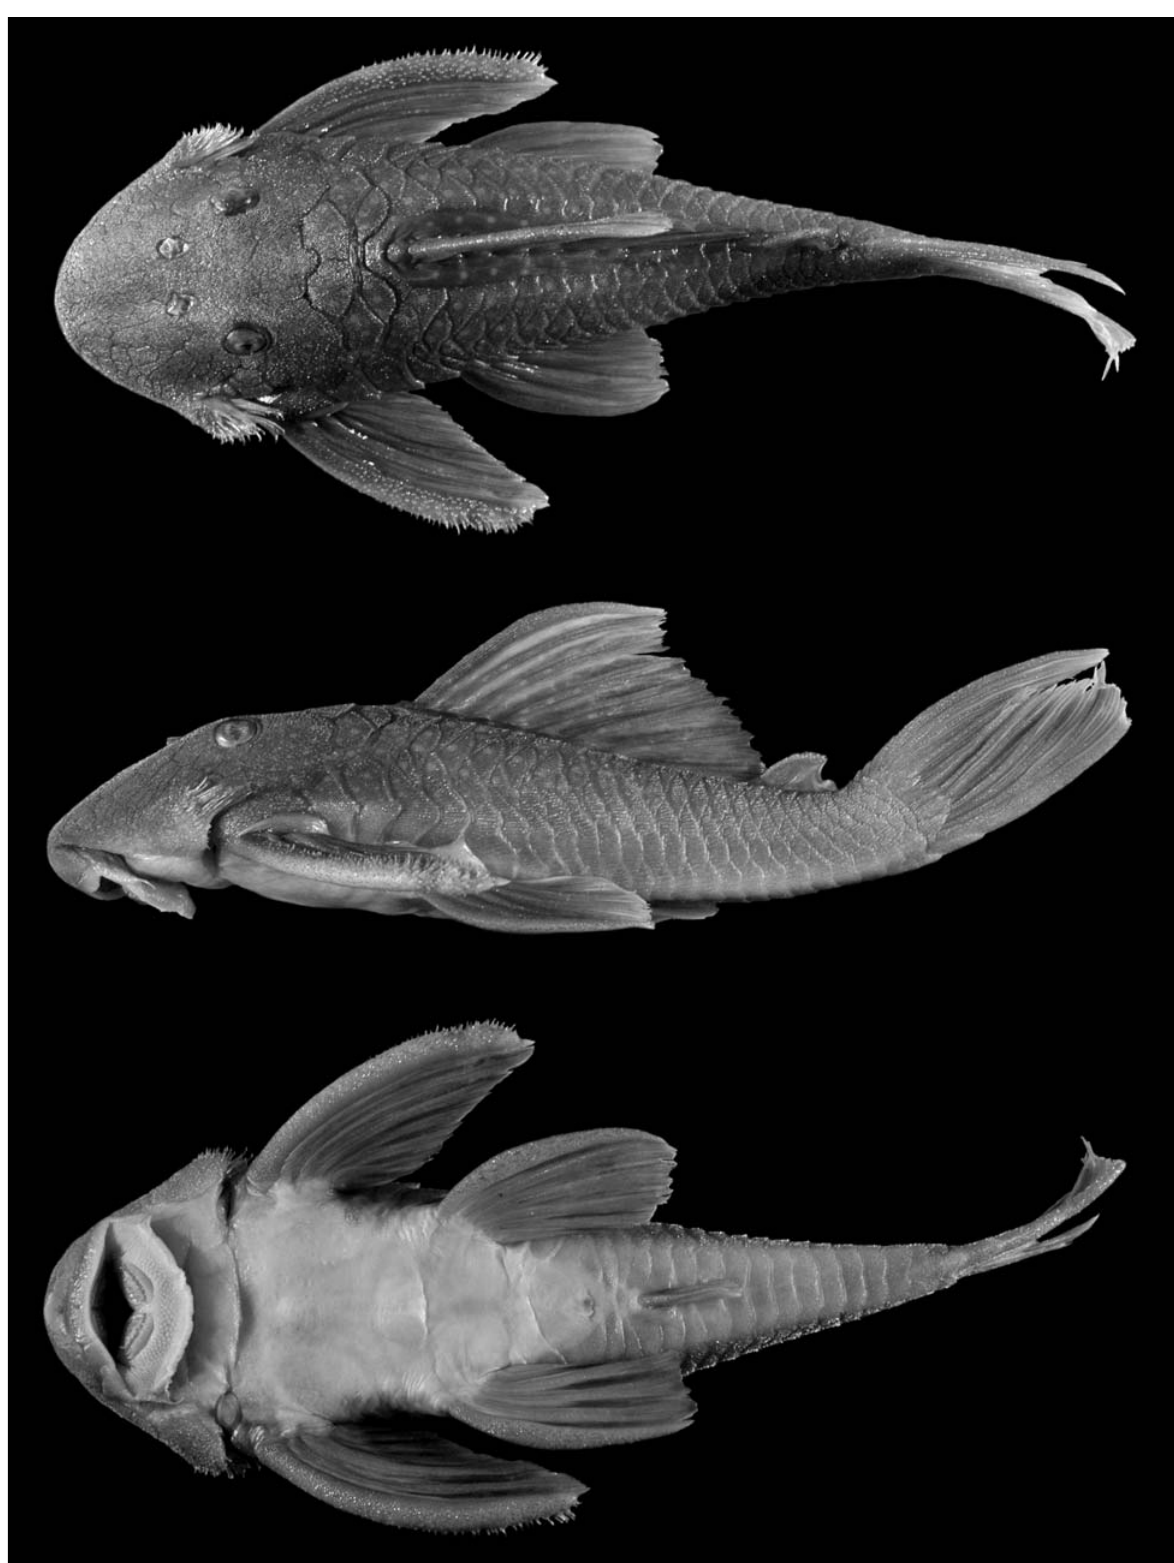
Fig. 4. Hemiancistrus subviridis MCNG 54032, 133.5 mm SL; holotype, dorsal, lateral, and ventral views. Photos by D.C.